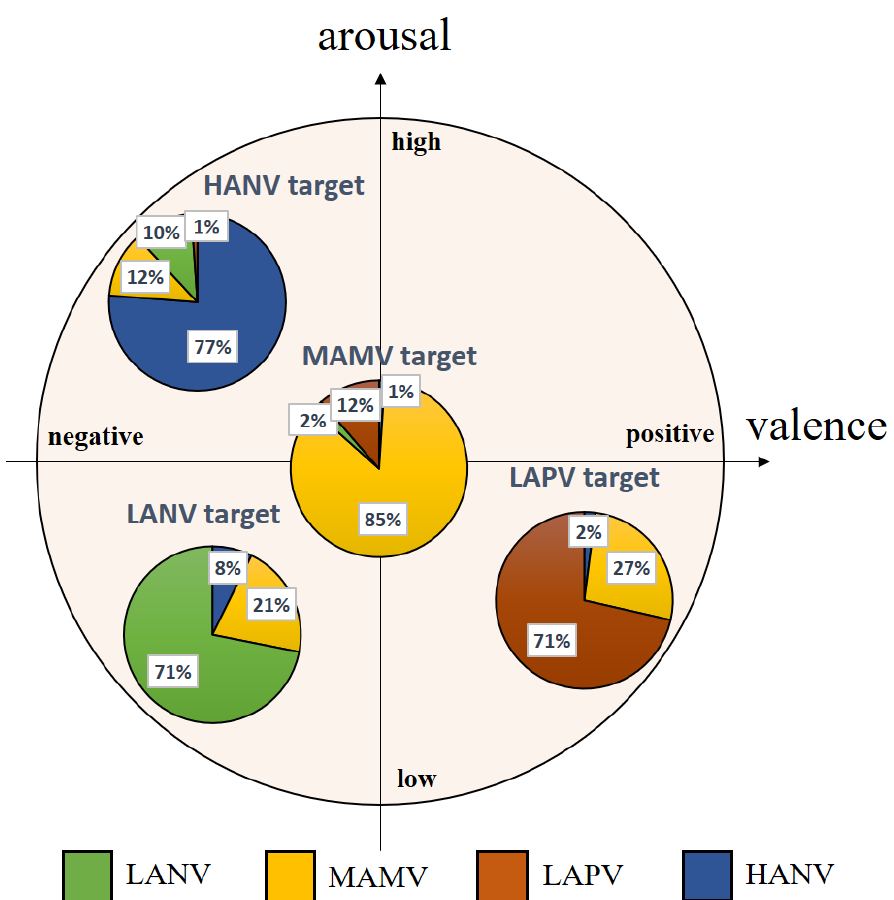
Figure 4. Subjective annotation in reference to objective annotation, in the valence–arousal space. HANV: High Arousal–Negative Valence, LANV: Low Arousal–Negative Valence, LAPV: Low Arousal–Positive Valence, MAMV: Medium Arousal–Medium